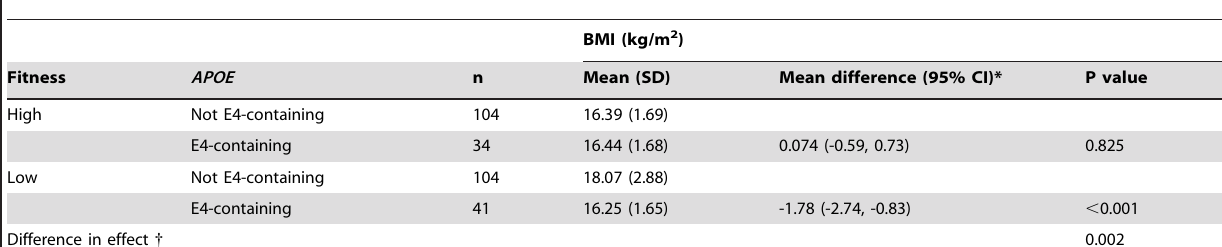
Table 3. Interaction between APOE genotype and fitness in determining BMI.